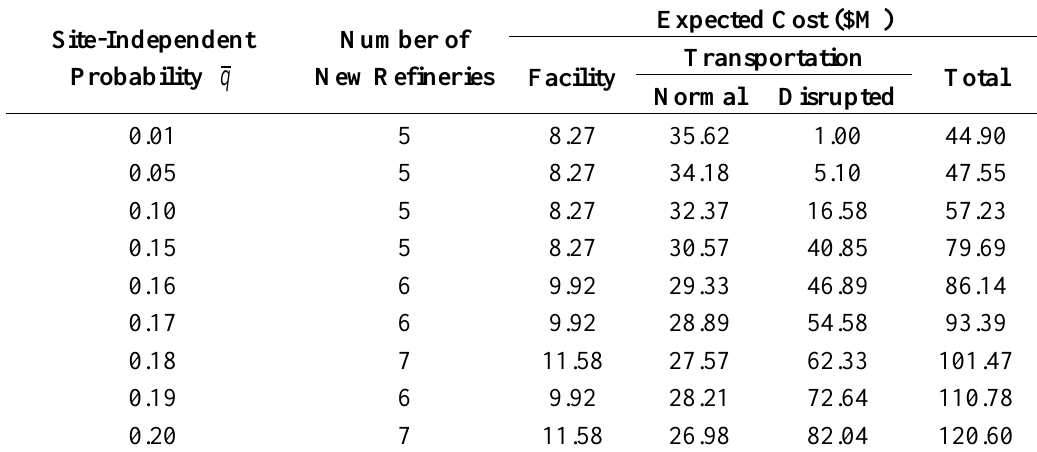
Table 4. Sensitivity of optimal solutions to site independent probability